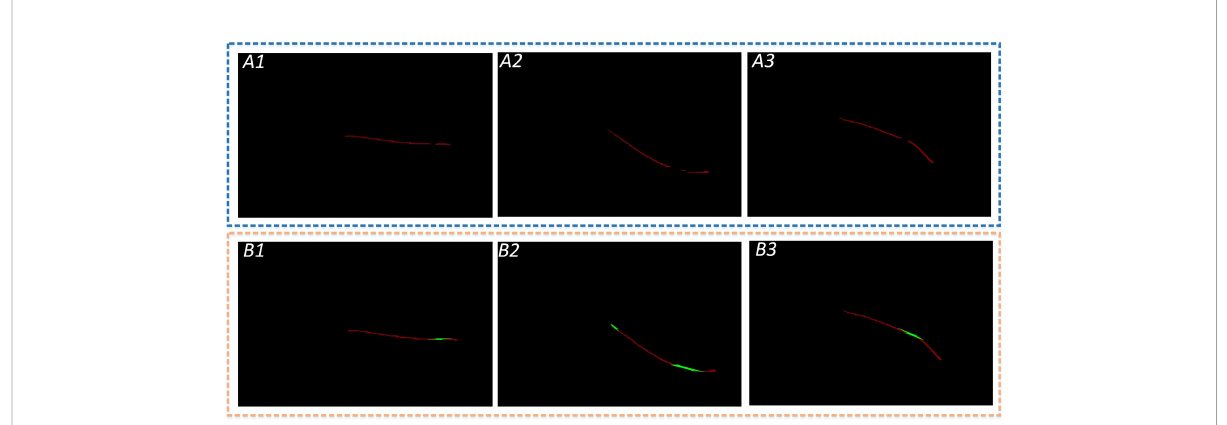
FIGURE 10 Leaf veins repair images. The A1, A2, and A3 show that the segmented leaf vein regions pass through MobileNetV2-DeepLabV3+, and all three images have leaf vein occlusion, resulting in incomplete segmentation; B1, B2, and B3 show that the leaf veins were repaired using the Convex Hull-Scan